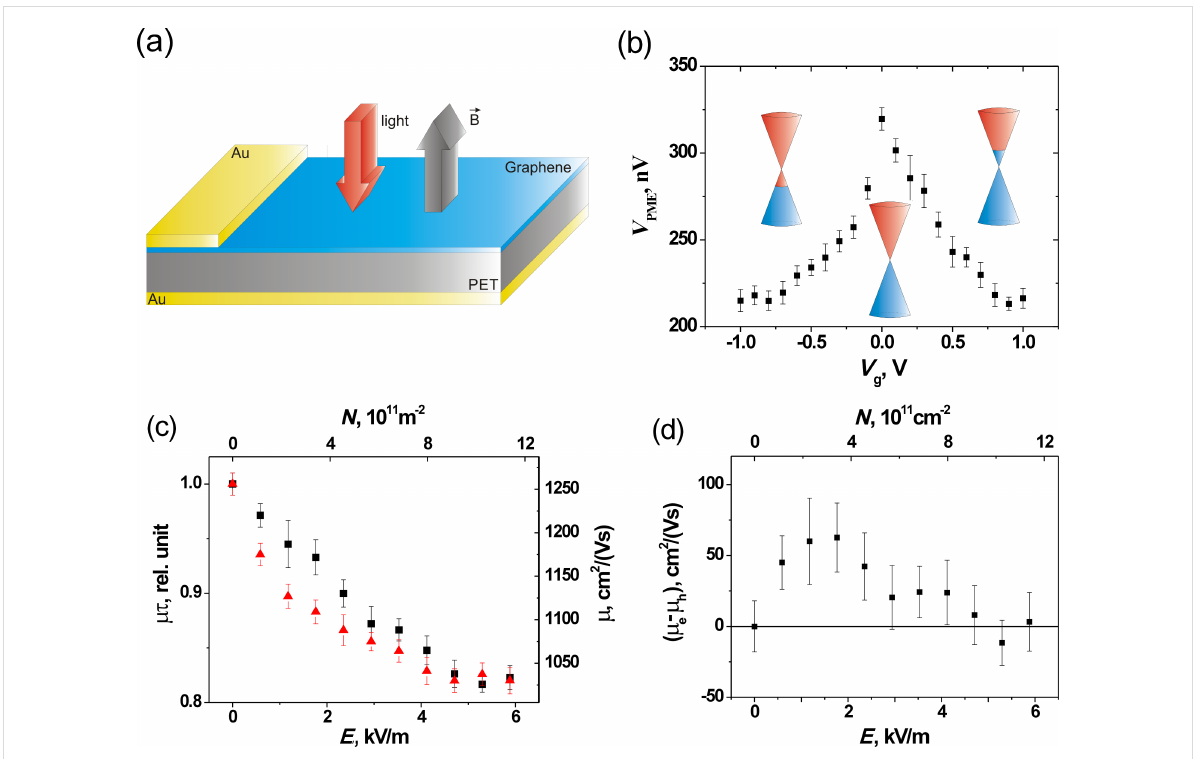
Figure 6: Schematic representation (a) of a back-gated sample used for the PME-Corbino investigations of graphene with electrostatically tunable carrier density; (b) PME voltage response vs gate voltage ( B = 0.45 T; I = 2.6·10 22 photons/(m 2 s); f = 72 kHz; the inserts depicts the positions of the Fermi energy in the conduction and valence bands); (c) product of mobility and lifetime (left axis) as well as the mobility (right axis) of electrons (black squares) and holes (red triangles) vs electric field (bottom axis) and concentration of electrostatically induced carriers (top axis); (d) difference be- tween electron and hole mobilities vs electric field (bottom axis) and concentration of electrostatically induced carriers (top